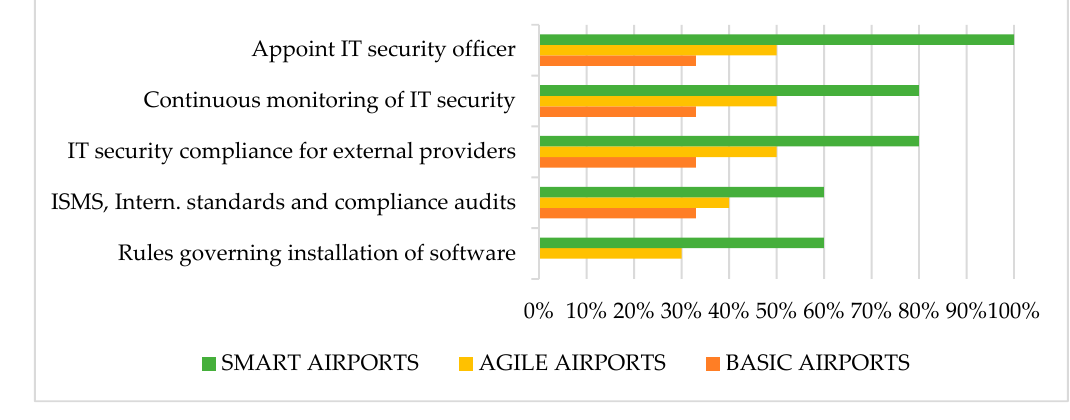
Figure 5. Good practices for policies and standards